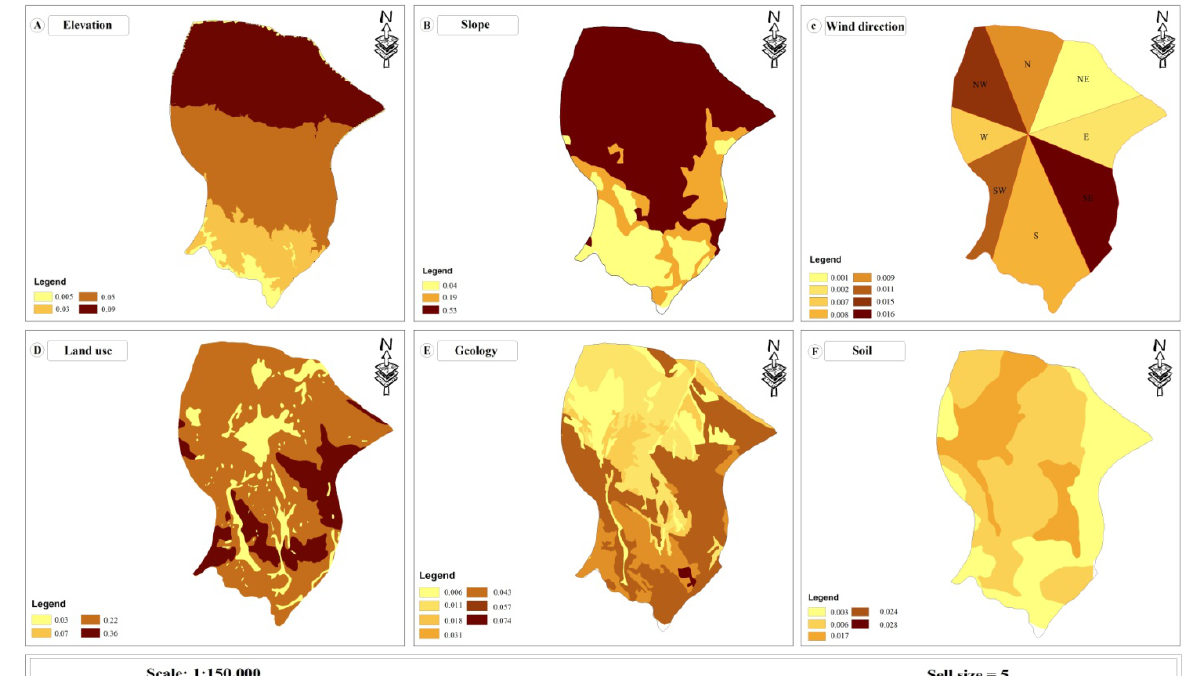
Figure 8. The raster maps calculated by ANP model